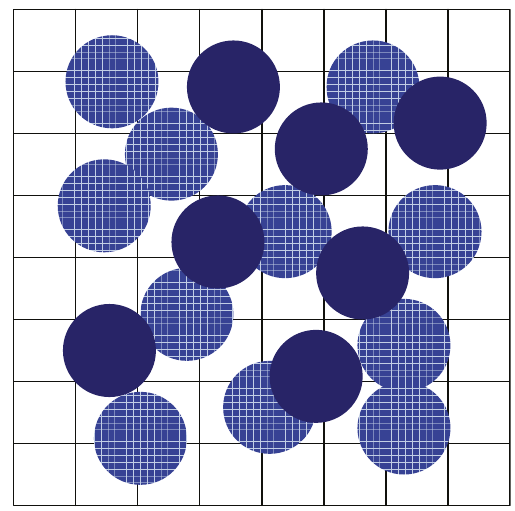
Figure 1: Hybrid sensor network consisting of both static and mobile nodes: solid circles-mobile nodes and checked circles-static